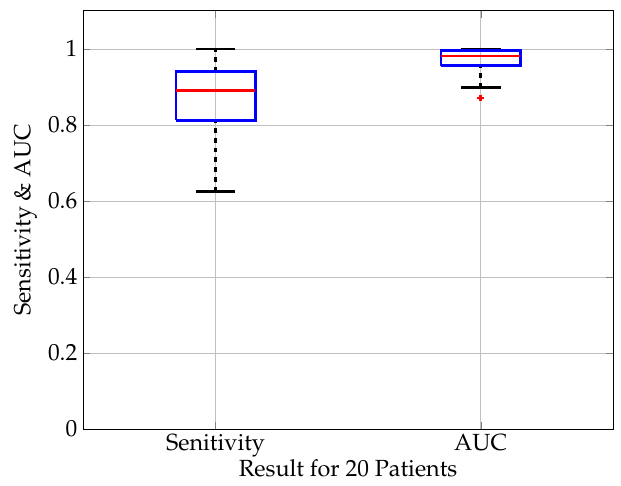
Figure 5. Boxplot (median value (red), lower and upper quartile (blue), min. and max. value (black), outlier (red cross)) of the evaluation measures sensitivity and AUC score for 20 patients. The median sensitivity is 0.90, 75 percentile: 0.94, 25 percentile: 0.81. The median AUC score is 0.98, 75 percentile: 0.99, 25 percentile: 0.98.